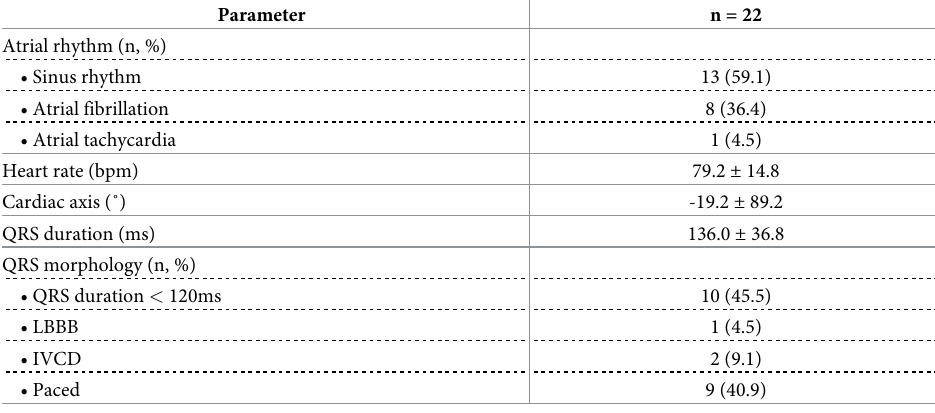
Table 2. Electrocardiographic parameters (n = 22) before implantation of the left ventricular assist device. Parameter n = 22 Atrial rhythm (n,